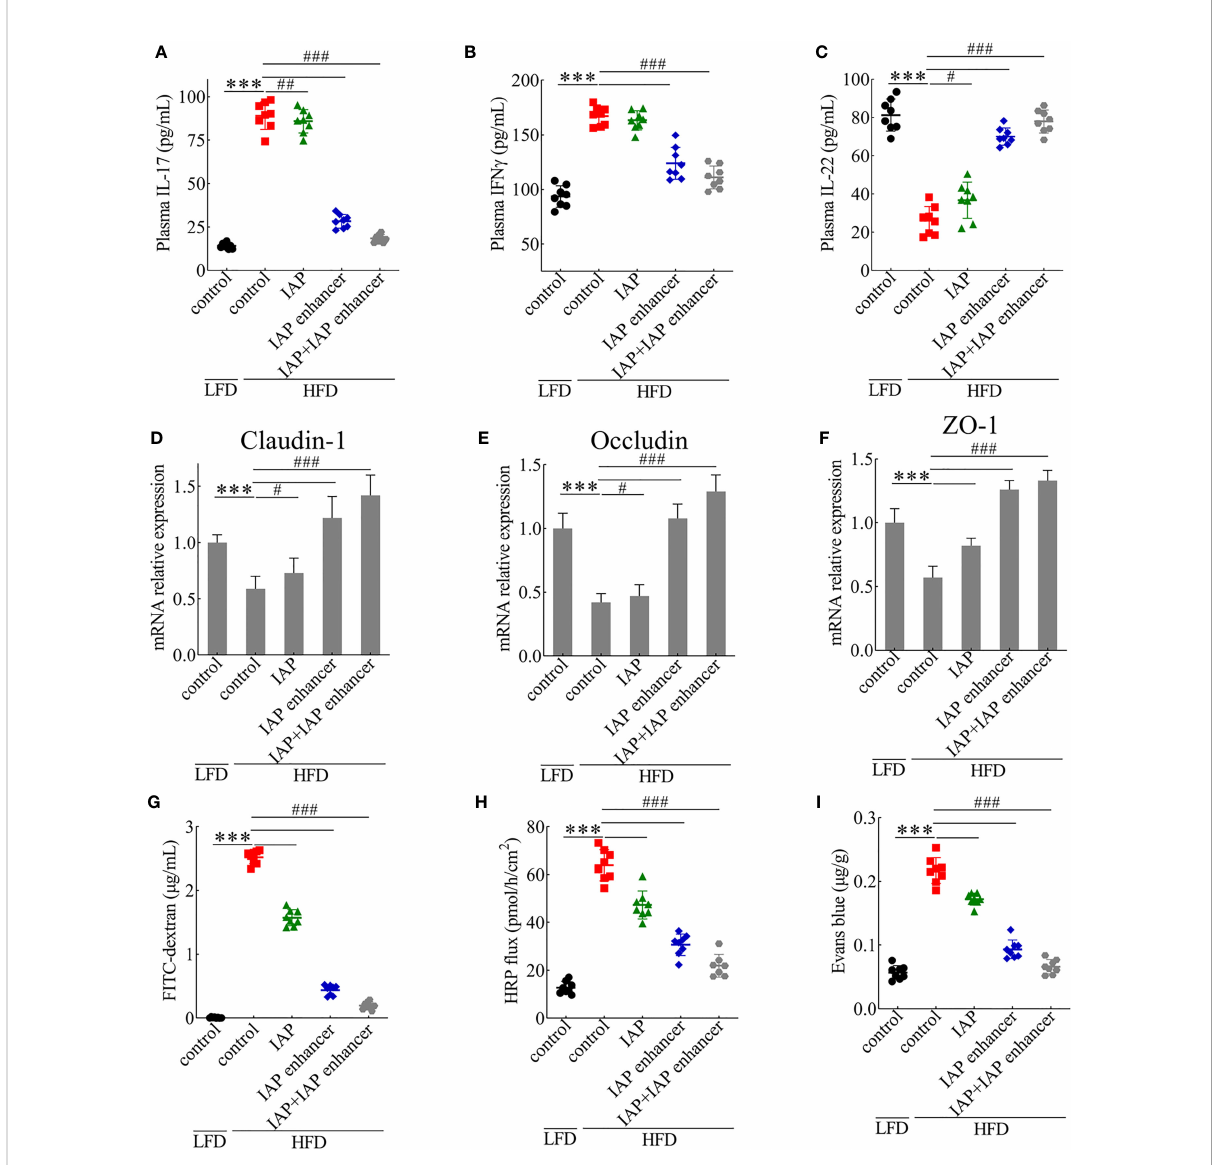
FIGURE 3 IAP + IAP enhancer prevents HFD-induced intestinal permeability injury. (A) IL-17. (B) IFN g . (C) IL-22. The relative mRNA expression levels (D) claudin-1, (E) occludin, and (F) ZO-1. Intestinal permeability as determined by (G) FITC-dextran (70 kDa), (H) HRP fl ux ex vivo, and (I) Evans blue in vivo after oral gavage. Values are presented as means ± SD (n = 8/group). Two-tailed unpaired Student ’ s t test. HF control groups compared with the LF control groups, ***P < 0.001; HF treatment groups compared with the HF control groups, # P < 0.05, ## P < 0.01, ### P <